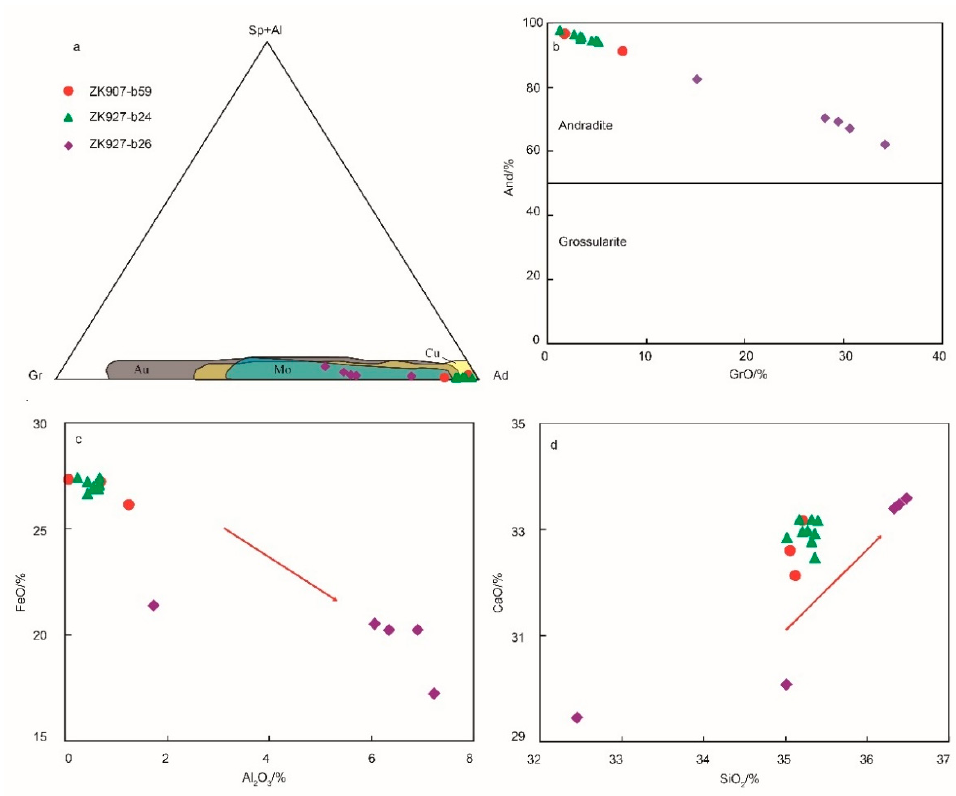
Figure 12. ( a ) Classification of garnets [65], ( b ) And–GrO of garnets, ( c ) Fe 2 O 3 / Al 2 O 3 of garnets, and ( d ) CaO–SiO 2 of garnets from Hucunnan Cu–Mo deposit. And, andradite; Gr, grossularite; Sp, spessartite; Al, almandine.